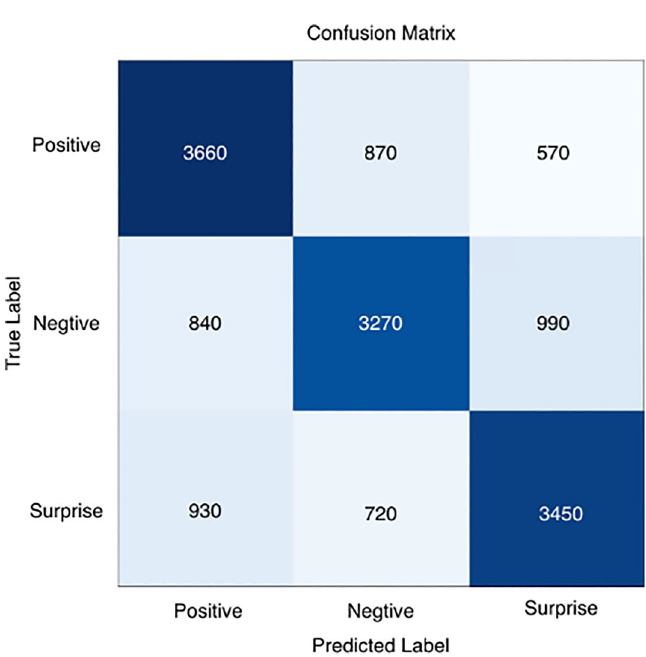
Figure 10. ShuffleNetV2 with CBAM is pre-trained and the classifier uses